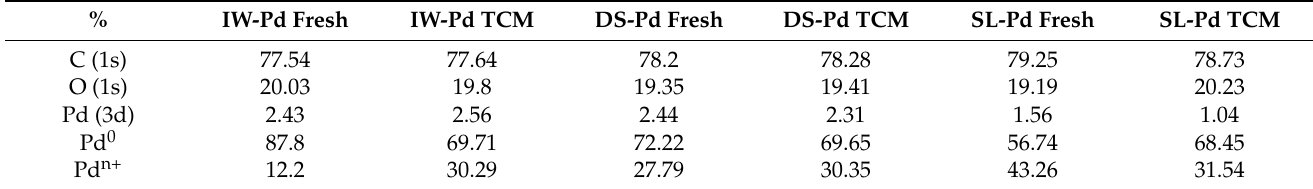
Table 2. Chemical compositions and oxidation states of Pd obtained from XPS analyses for the fresh reduced and used Pd/OMC catalysts.